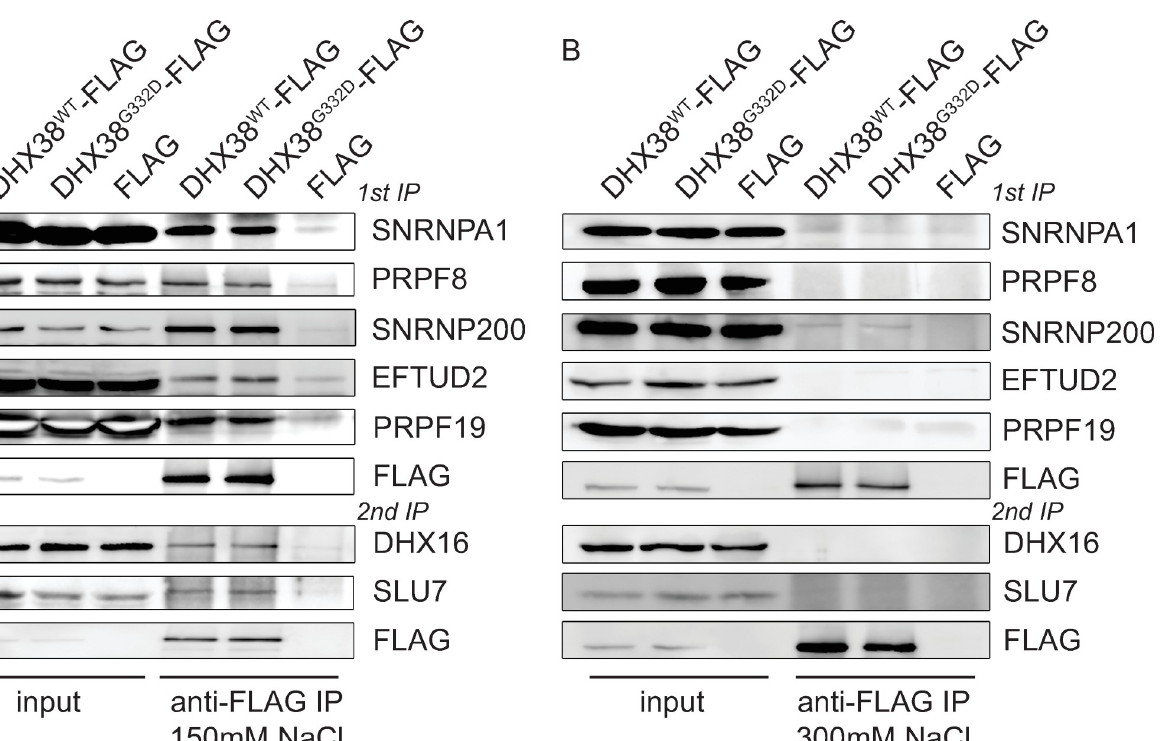
PLOS ONE | https://doi.org/10.1371/journal.pone.0265742 April 6,